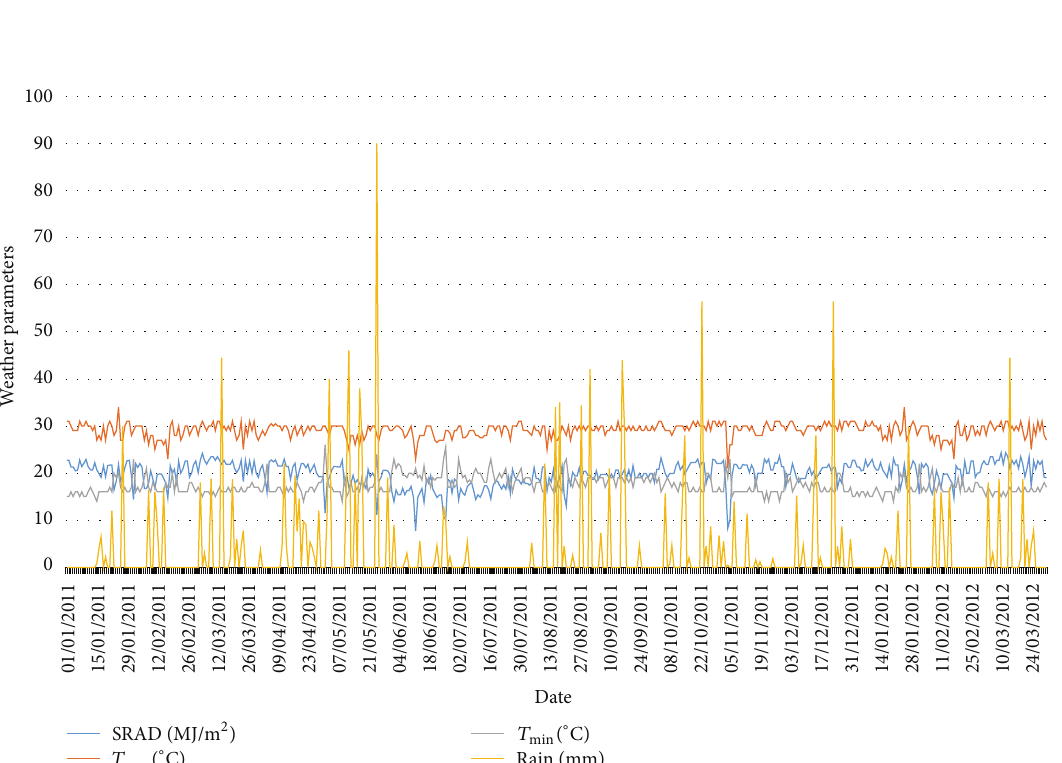
Figure 3: West Kano Weather for 2011.